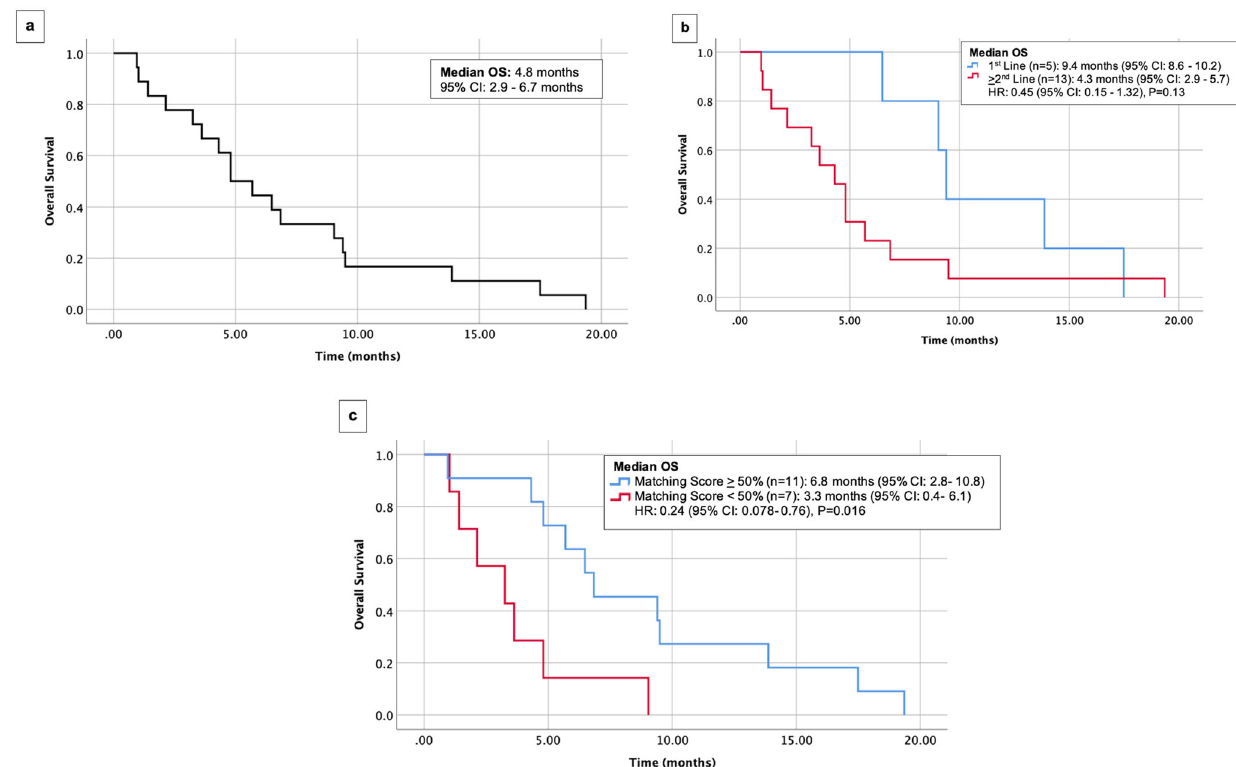
Fig. 2 Overall survival (OS) among 18 patients with pancreatic cancer who received matched therapy. a OS in 18 patients. b OS in 5 patients who received targeted therapy as fi rst line versus 13 patients who received it as ≥ 2nd line. c OS in 11 patients with matching score ≥ 50% versus 7 patients with matching score <50%. CI con fi dence interval, OS overall